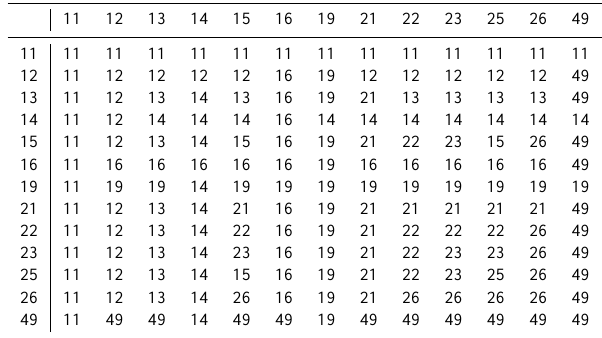
Table 8. Decision matrix indicating the fire type-protection type code of the record to be retained in the FPA FOD from a set includ- ing two or more redundant federal fire reports. The first digit of the code indicates fire type, where 1 = actionable (i.e., suppression or appropriate management response taken), 2 = natural out, and 4 = fuels management (unplanned ignitions only). The second digit of the code indicates protection type, as defined in Table